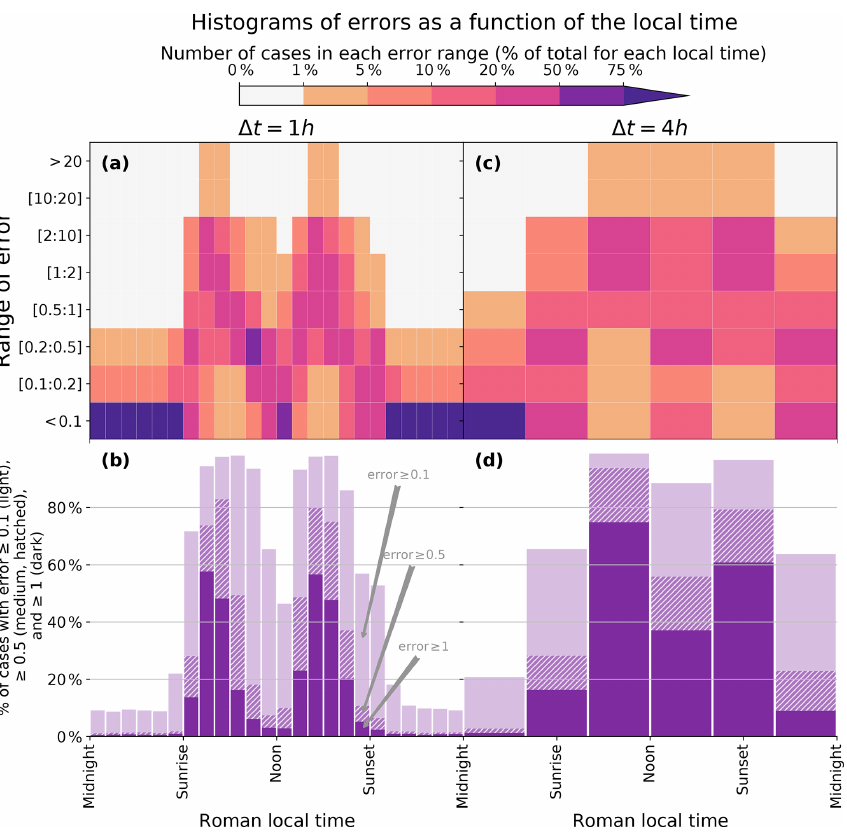
Figure 7. Histograms of errors as a function of the Roman local time and error classes for the parallel experiments. Left panels (a, b) are for (cid:49)t = 1h and right panels (c, d) for (cid:49)t = 4h. Top (a, c) panels show the percentage of cases in space × time in each range of error as a function of the Roman local time. The Roman local time is the local time piecewise-stretched: the time from midnight to sunrise is divided into 6 regular pseudo-hours. The same method is applied to the intervals sunset to noon, noon to sunset and sunset to midnight. This is similar to the division of the day in ancient Rome (Wikipedia, 2020). The percentages are computed with respect to the total number of cases for each local time. Bottom panels (b, d) show the number of cases with errors larger than 0.1 (light purple), 0.5 (medium purple with hatches) and 1.0 (dark